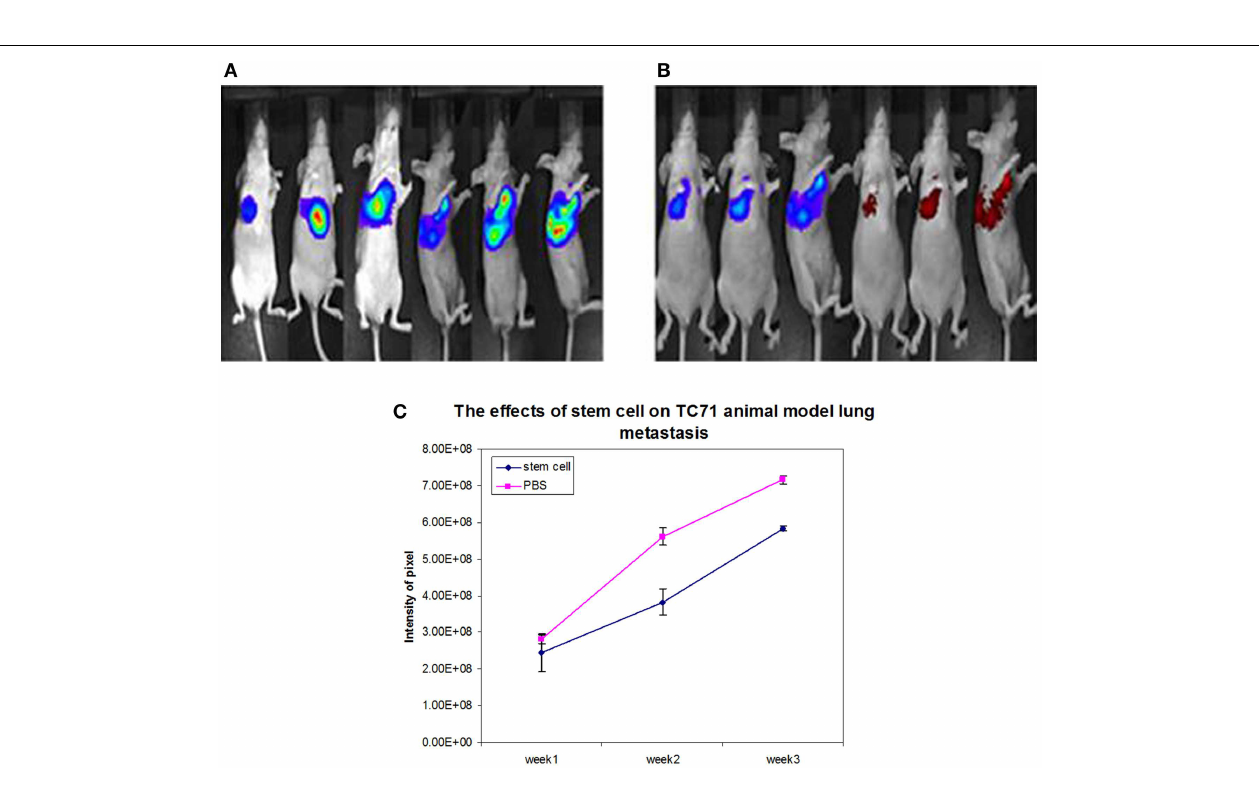
decreased blue signal. In addition, the injected MSCs were found to preferentially migrate to and engraft at the tumor sites as indicated by red intensity. (C) Quantification of the signal from the luciferase reporter shows a significant decrease in tumor burden 2 and 3weeks after the completion of MSC